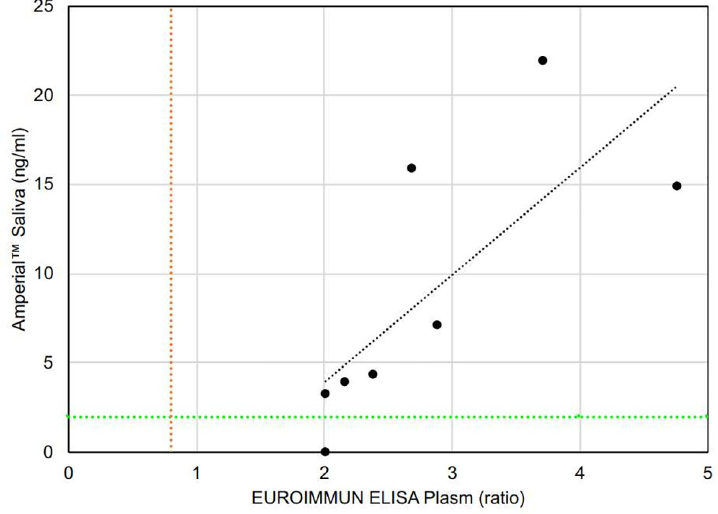
Fig 9. COVID-19 antibody level in paired saliva and plasma of COVID-19 (n = 8) subjects in a blinded randomized cohort. Plasma antibodies level are measured by EUROIMMUN ELISA reported in ratio (proportion of OD of calibrator to OD of sample) and saliva antibodies are measured by Amperial ™ in pg / ml. Green dashed line indicates 5 SD reference range cutoff of Amperial ™ test and red dashed line is reference range for EUROIMMUN